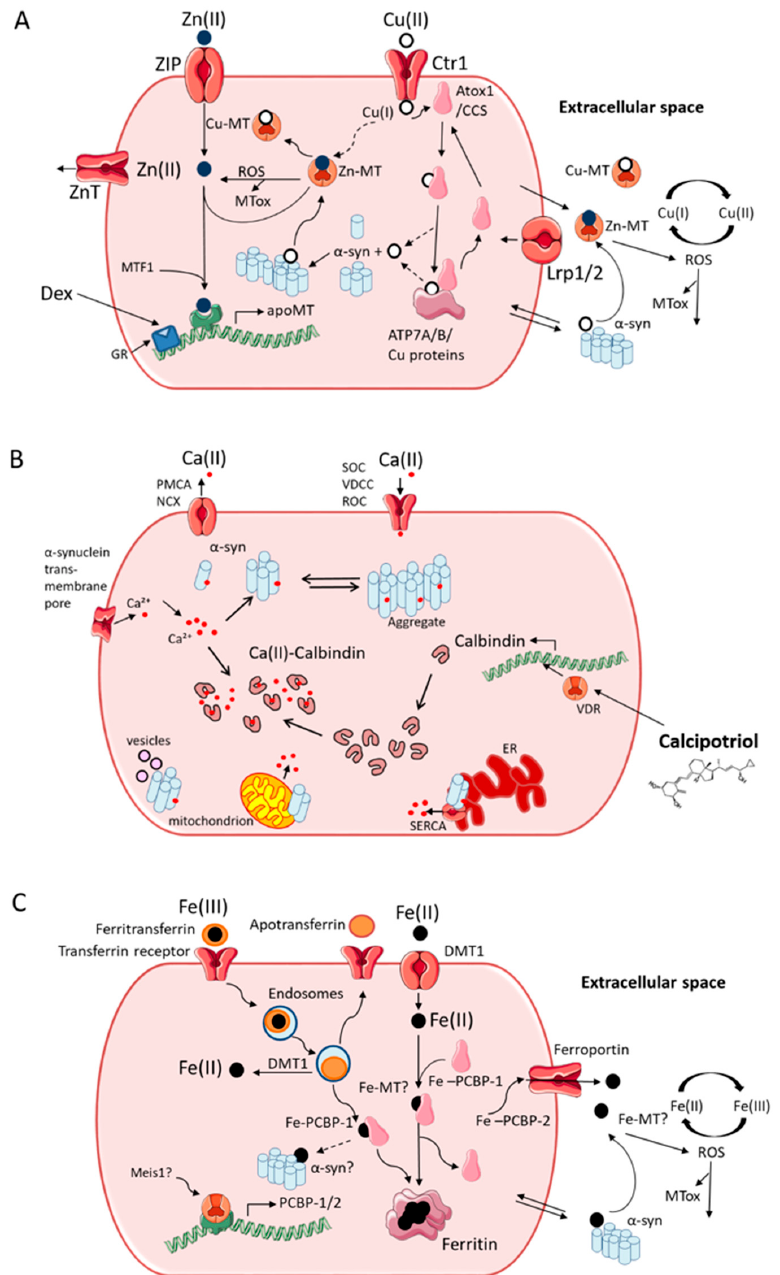
Figure 2. Interactions between metal ion homeostatic mechanisms and α -syn aggregation. ( A ) Cu homeostasis, α -syn and metallothionein (MT) induction. Cu enters via CTR1, then transfers to either Atox1 or CCS transporters that shuttle Cu to either ATP7A/B pumps or SOD1, respectively. MT may buffer labile Cu that spills over from these pathways. Cu binding to α -syn can induce aggregation. Zn-MT can remove Cu from α -syn. MT is also a potent ROS scavenger. Both MT and α -syn can be secreted by and taken up by cells. MT transcription is induced by MTF1 in response to Zn and by glucocorticoids via the glucocorticoid receptor. The glucocorticoid analogue, dexamethasone, induces MT and can block Cu-dependent α -syn aggregation. MTF1, metal-responsive transcription factor-1; MTox, oxidized MT; Dex, dexamethasone; GR, glucocorticoid receptor; ZnT, zinc transporter; CTR-1, copper transporter 1; CuMT, copper MT; apoMT, metal-free MT; Lrp1/2, Low density lipoprotein receptor-related protein 1/2; ZIP, zinc importer protein. ( B ) Ca homeostasis, α -syn and calbindin- D28k induction. Ca enters via ligand and voltage-gate channels and is rectified by plasma membrane